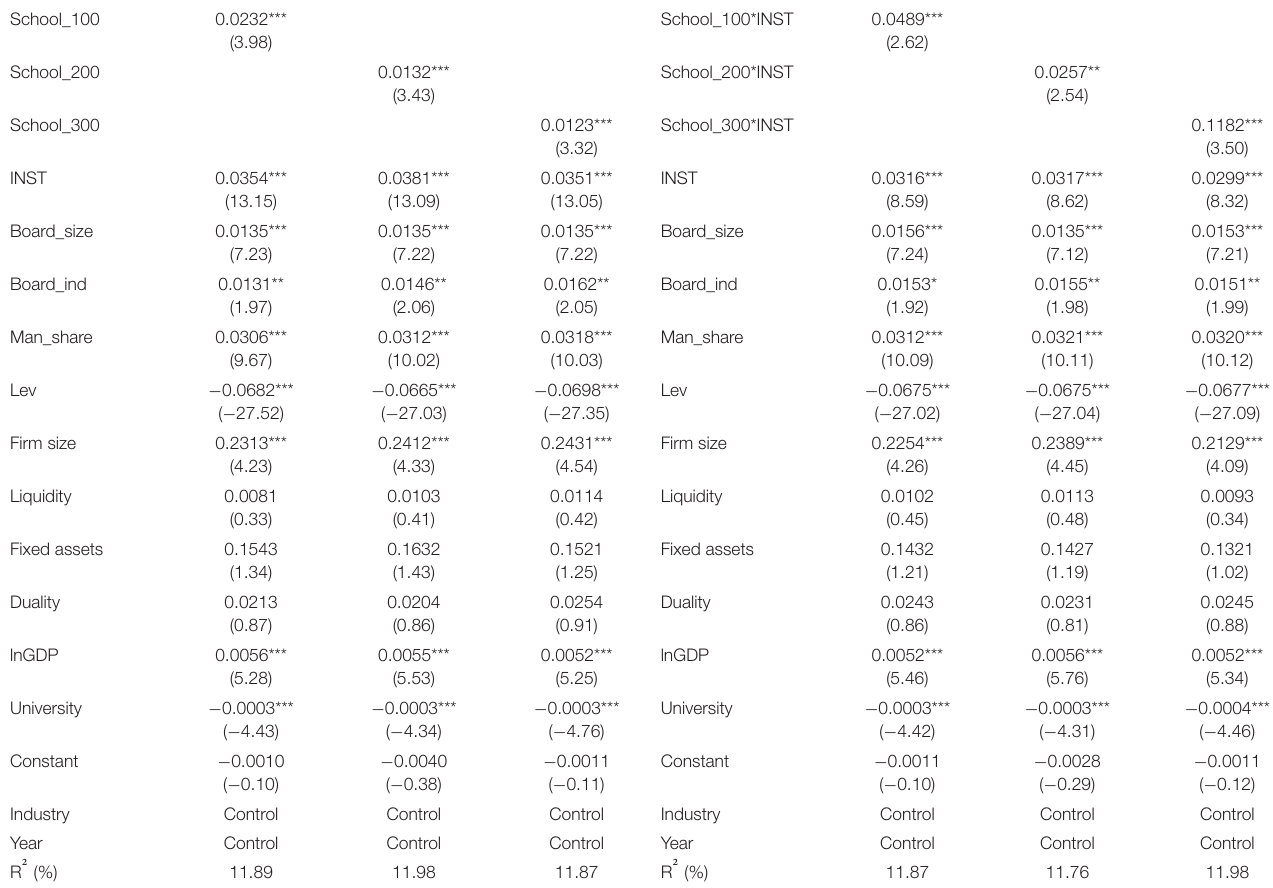
TABLE 3 | The impact of Confucianism on firm performance. TABLE 4 | Moderating effect of institutional